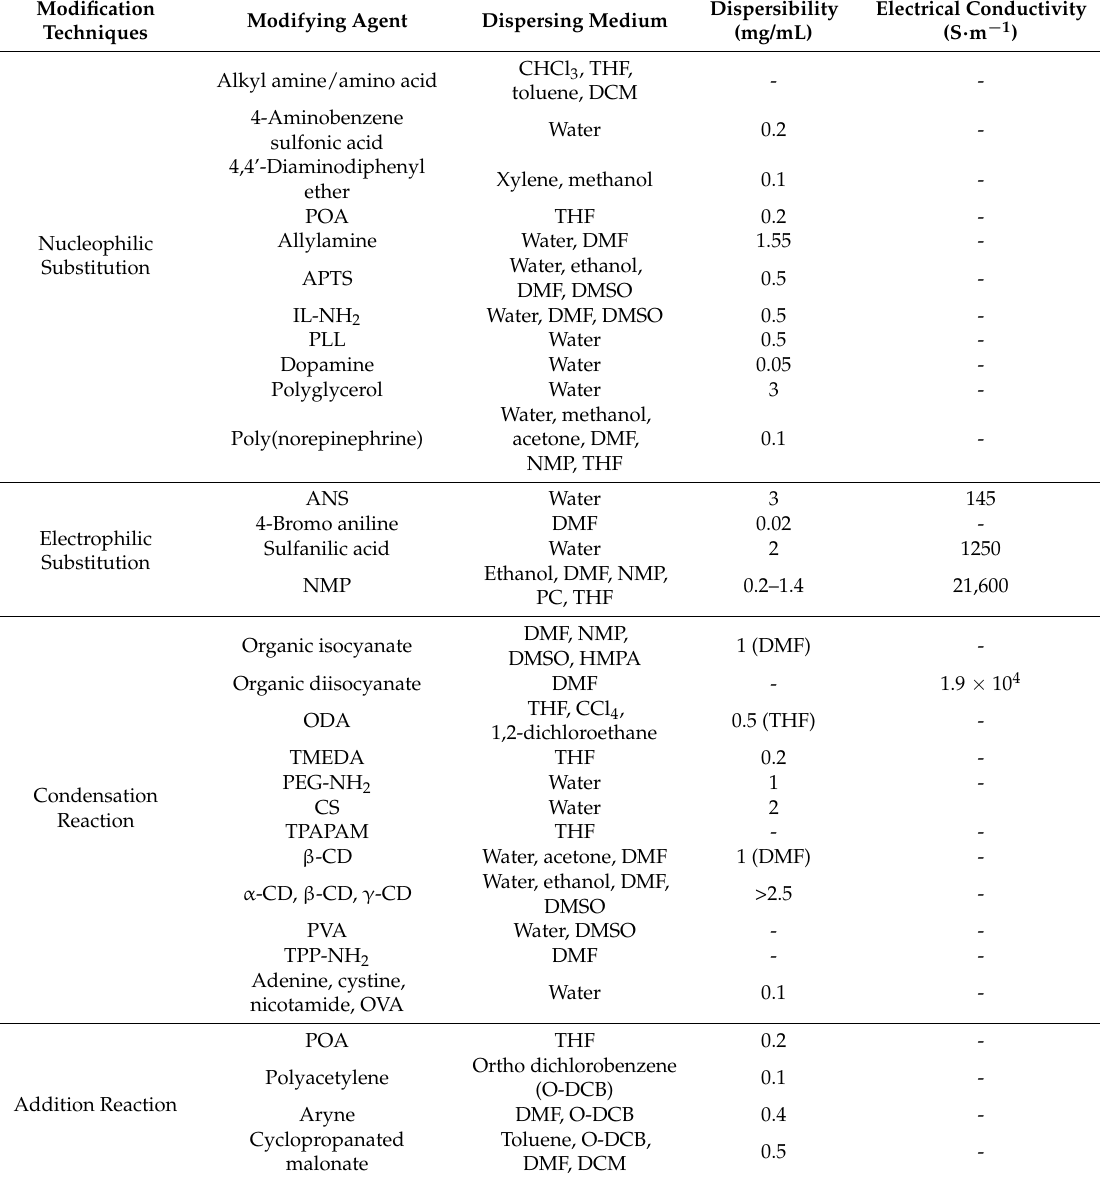
Table 5. Comparison of covalent dispersion techniques dispersibility and electrical conductivity. Reproduced with permission from Tapas Kuila et al., Progress in Materials Science; published by Elsevier, 2012